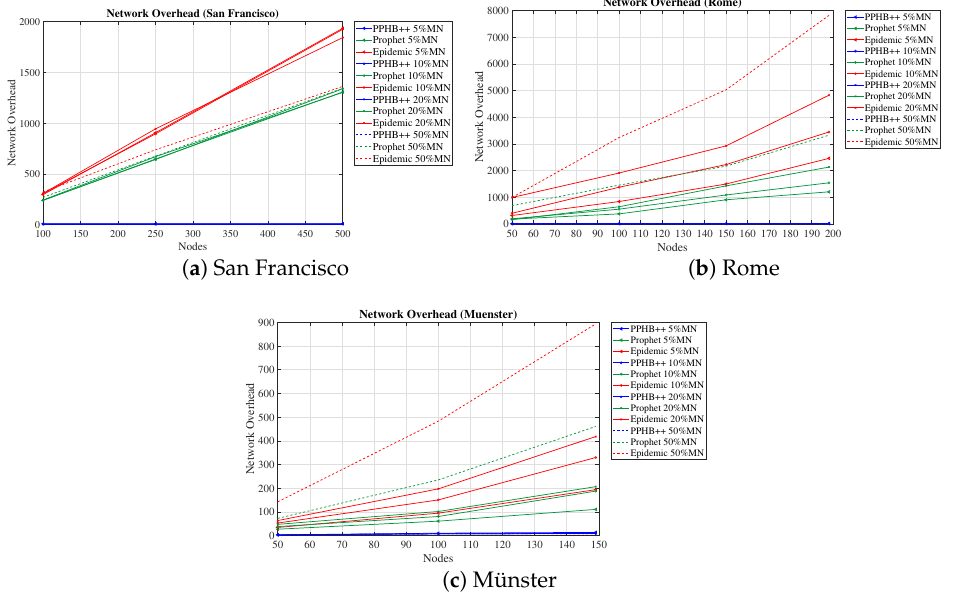
Figure 8. Network overhead (NetO) for the three cities of San Francisco, Rome, and Münster with the presence of malicious